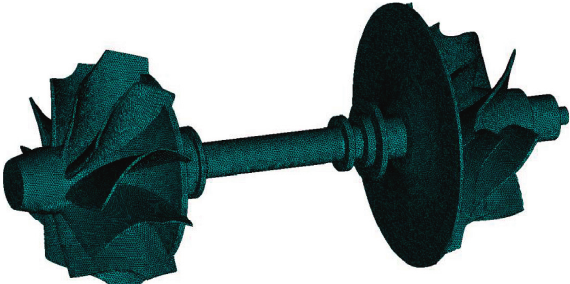
Figure 11: Global grid of rotor-shaft system.